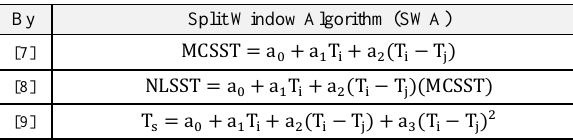
Table 1. Different split window algorithm customized in this study.